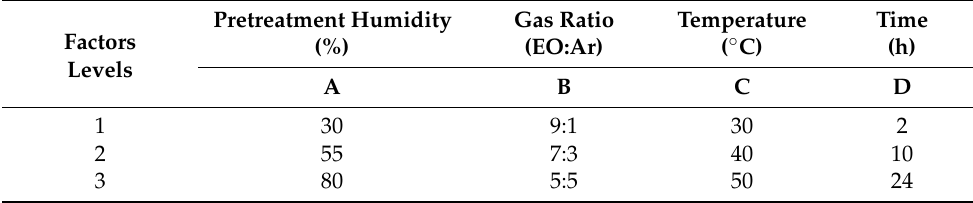
Table 2. Factor level